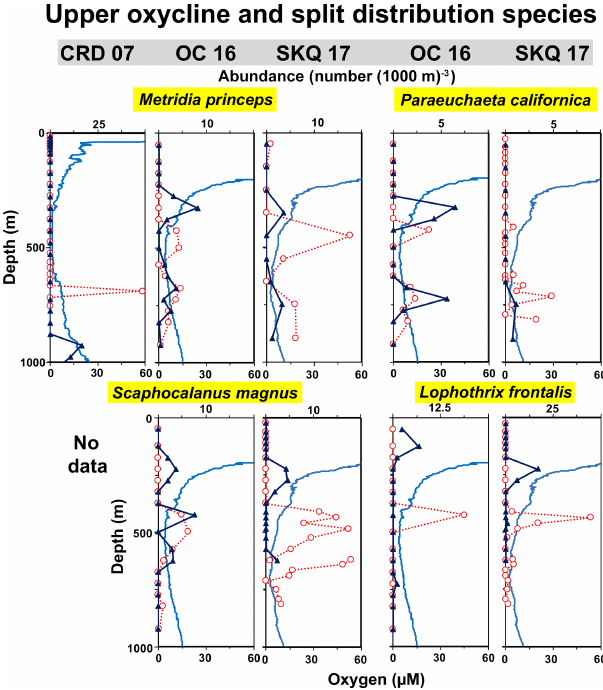
Figure 7. Vertical distributions relative to oxygen: upper oxycline species and those with split oxycline distributions. Two species are shown in each row with stations repeated for each half. See Fig. 3 caption for more